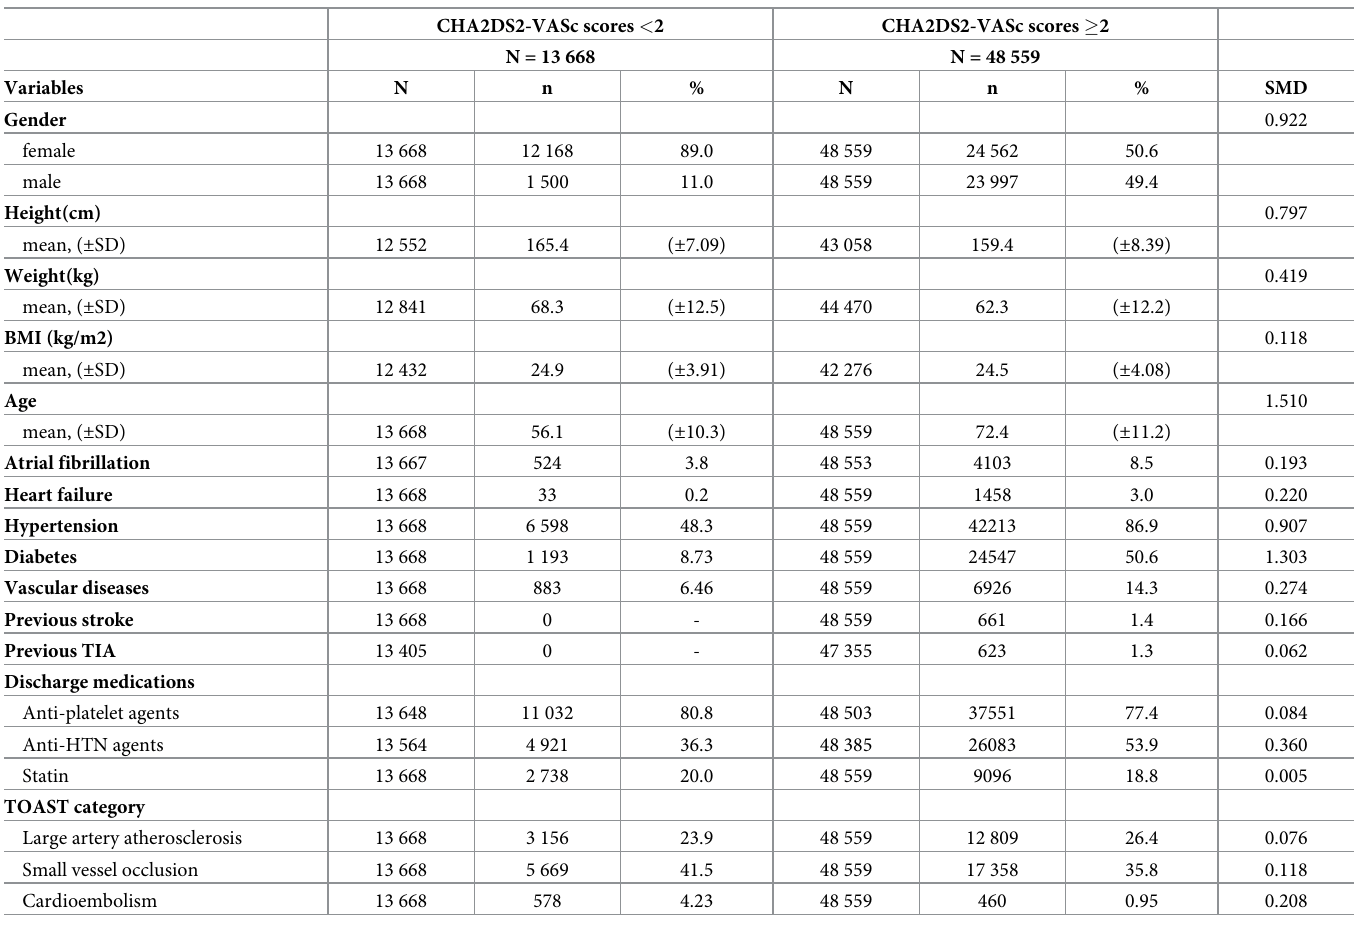
Table 1. Characteristics and comorbidities of patients at